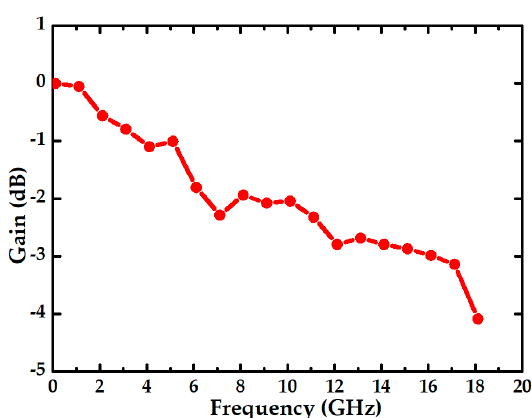
Figure 15. Measured bandwidth.